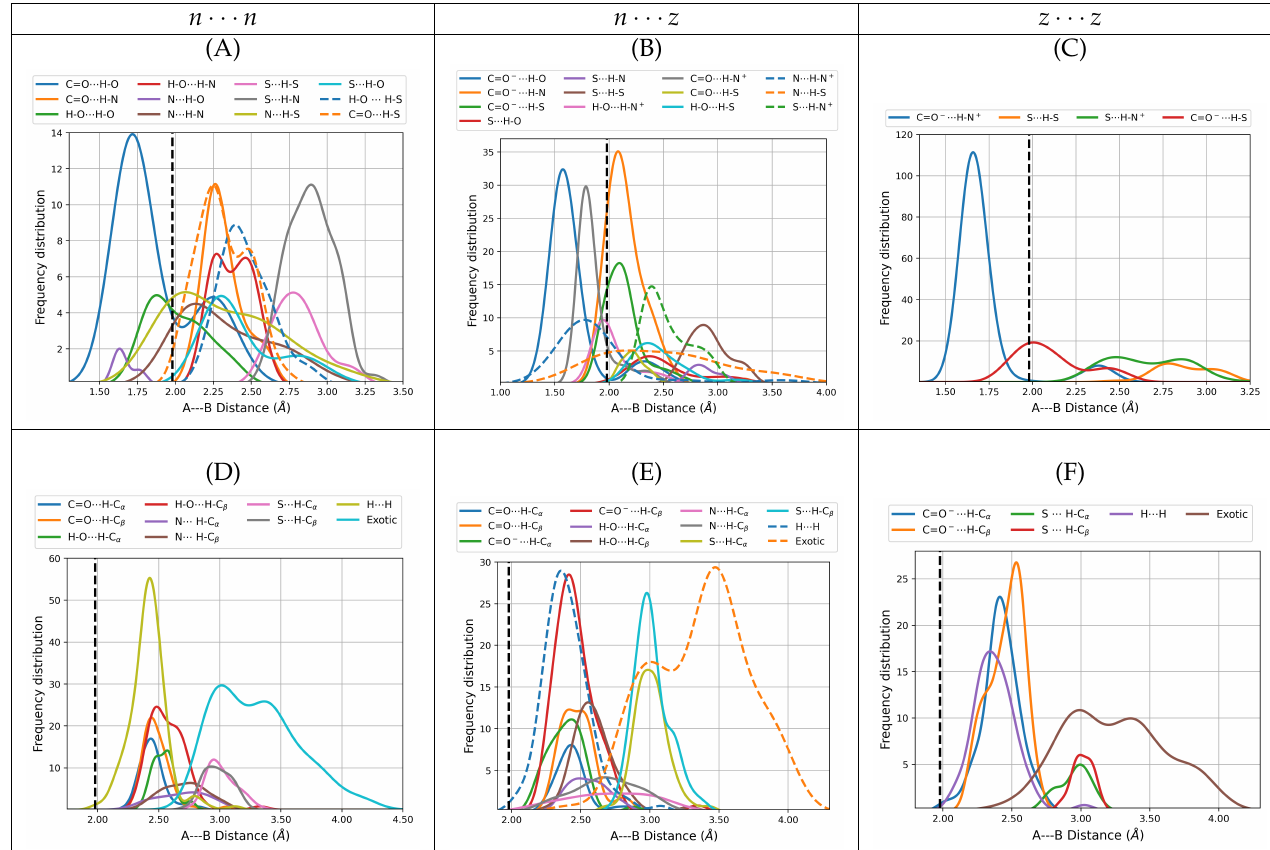
Figure 3. Distributions of the A · · · B distances for intermolecular contacts for all dimers of cysteine found in this work. The distributions are fitted to the actual histograms, so the center of the peaks of the distributions are statistically relevant. The top row shows only primary hydrogen bonds including salt bridges. The bottom row shows secondary hydrogen bonds, dihydrogen bonds, and all exotic interactions. The left column is reserved for the n · · · n dimers (subfigures ( A , D )), the middle column for n · · · z (subfigures ( B , E )) and the right column for z · · · z (subfigures ( C , F )). All distances taken from the B3LYP–D3/6–311++G( d , p ) potential energy surfaces with water represented as a continuum solvent. The dashed vertical lines at 1.98 Å mark the reference H · · · O distance in the gas phase water dimer.